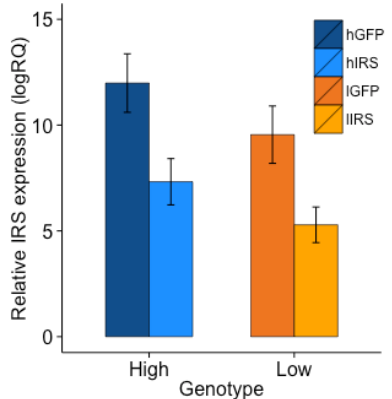
Figure 1. Expression of irs relative to β -actin . Bars are means ± s.e. irs expression was significantly reduced in both the high (Fisher’s LSD: high strain knockdown (hIRS, n = 18) vs high strain injected control (hGFP, n = 18), p = 0.0108) and the low (Fisher’s LSD: low strain knockdown (lIRS, n = 18) vs low strain injected control (lGFP, n = 18), p = 0.0359) strains following injection with dsRNA against the irs gene. High pollen hoarding workers had higher expression of irs than low strain workers. There was no interaction between treatment and genotype (F 2,63 = 0.0037, p = 0.9514).